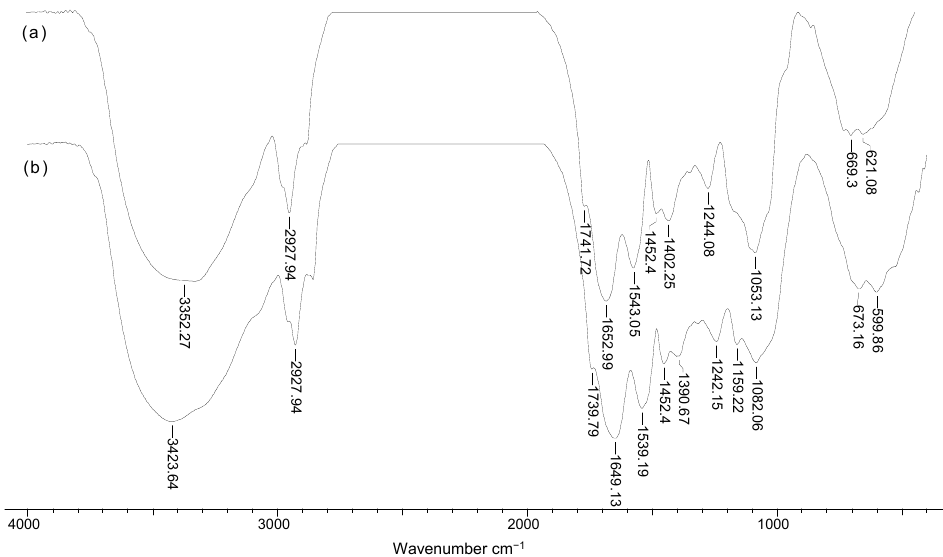
Figure 6. FTIR spectra of Na-SW biosorbent before ( a ) and after ( b ) Pb(II) ion biosorption from aqueous solution.